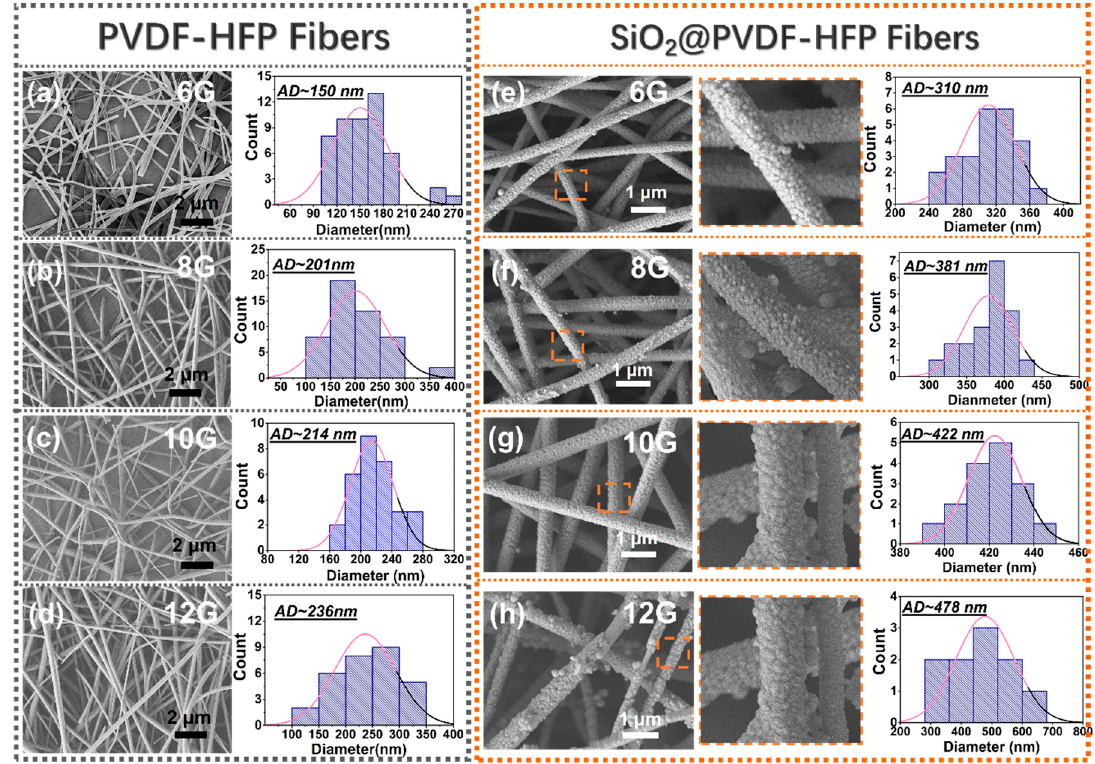
Figure 2. SEM images and statistical analysis of fiber diameters of PVDF-HFP and SiO 2 @PVDF-HFP nanofibrous membranes. ( a ), ( b ), ( c ), ( d ) PVDF-HFP-6, -8, -10 and -12 electrospun fibrous membranes. The average fiber diameters (AD) are 150 nm, 201 nm, 214 nm, and 236 nm, respectively. (Bar: 2 μ m) ( e ), ( f ), ( g ), ( h ) SiO 2 @PVDF-HFP-6, -8, -10 and -12 electrospun membranes. (Bar: 1 μ m). The corresponding enlarged zoomed views were exhibited in the orange dotted frames. SiO 2 particles were anchored on the fiber surfaces. The average fiber diameters are 310 nm, 381 nm, 422 nm, and 478 nm, respectively.